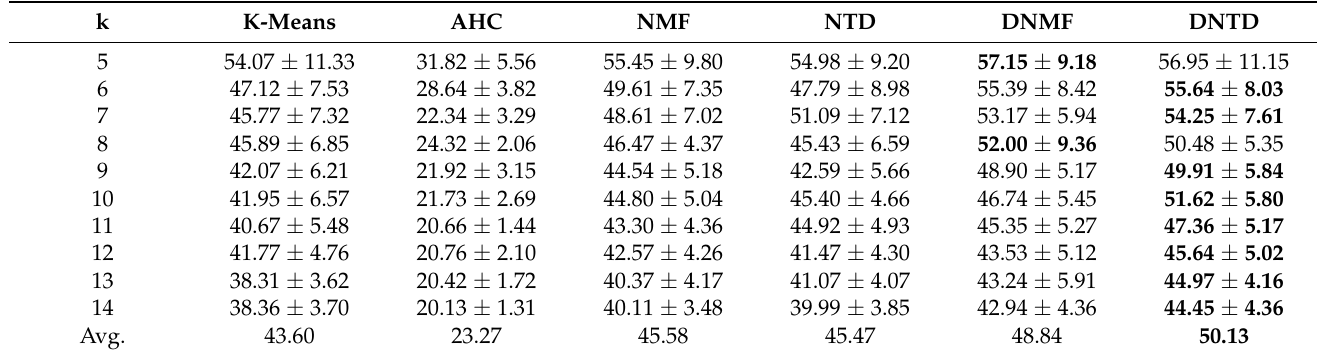
Table 5. AC (%) ± standard deviation (%) of different algorithms on Yale dataset.